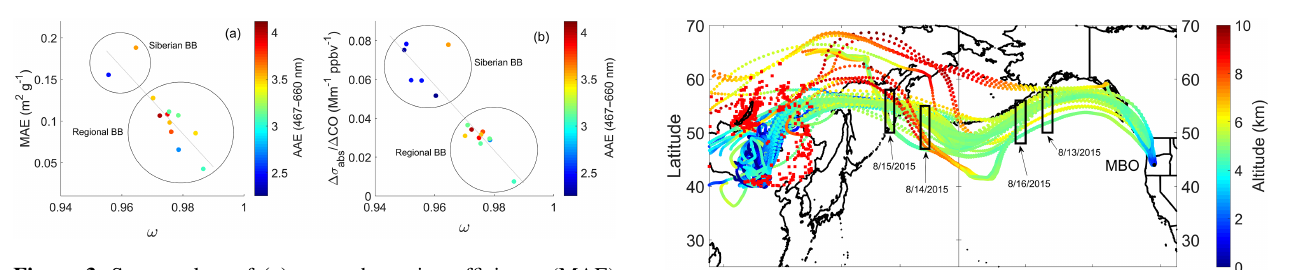
Figure 3. Scatter plots of (a) mass absorption efficiency (MAE) and (b) absorption enhancement ratio (cid:49)σ abs /(cid:49) CO vs. single scat- tering albedo ( ω) . MAE values were not calculated for four of the six Siberian-influenced events due to missing PM 1 data.